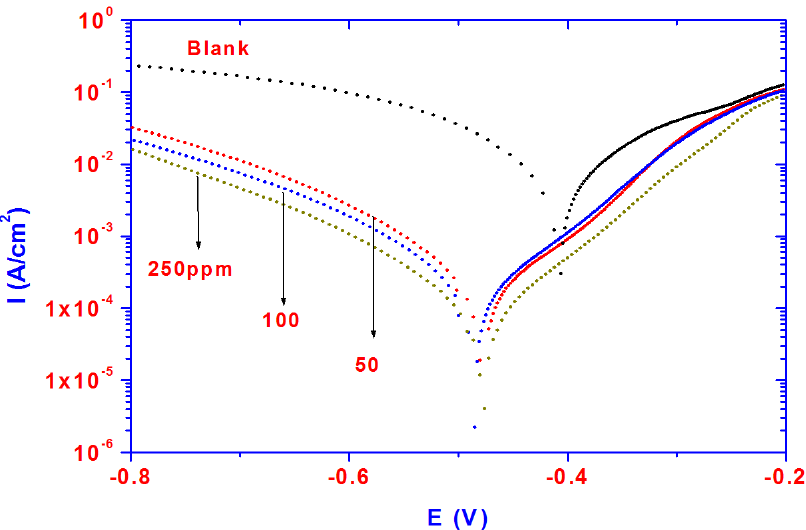
Figure 6. Polarization curves for steel in 1 M HCl solution containing different PAMPS- Na-co-St/magnetite